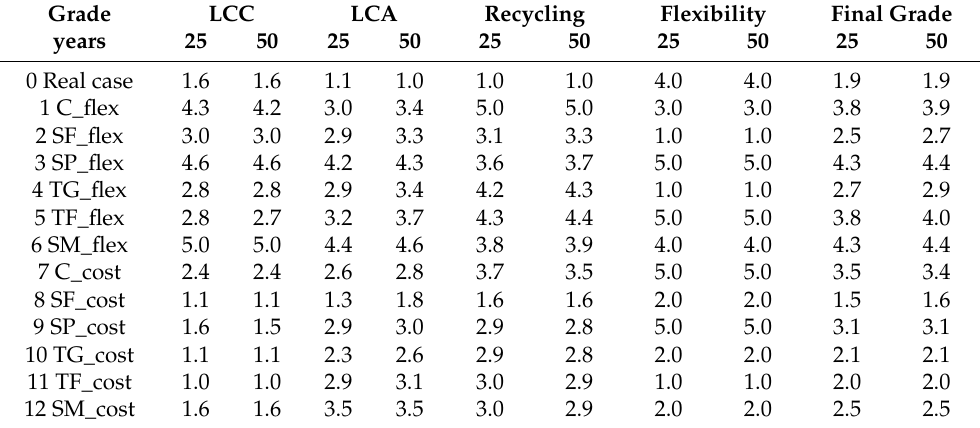
Table 6. Grading results of the LCC, LCA, recycling potential and flexibility rate of the examined building variants, respecting the impact of the structural and enclosure systems listed for the time scenarios of 25 and 50